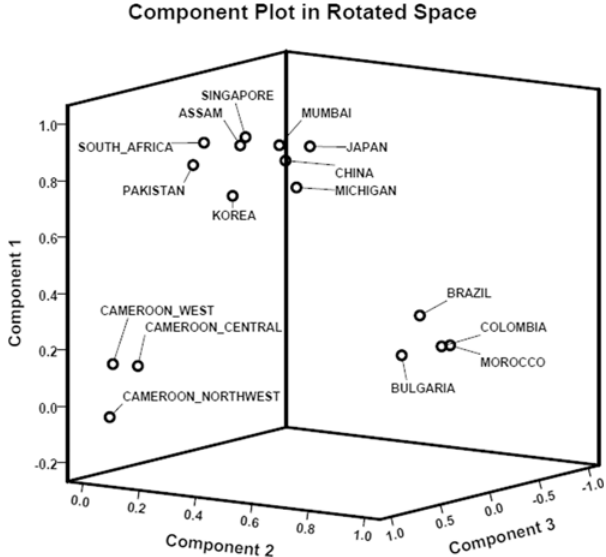
Fig 6. A three dimensional scatter plot based on principal component analysis (PCA) showing relatedness of different geographical regions based on their similarity in patterns of 12-loci MIRU-VNTR diversity in MTBC from Assam and other geographical localities. Different geographical areas were clustered in three groups and the state of Assam clustered with other Asian